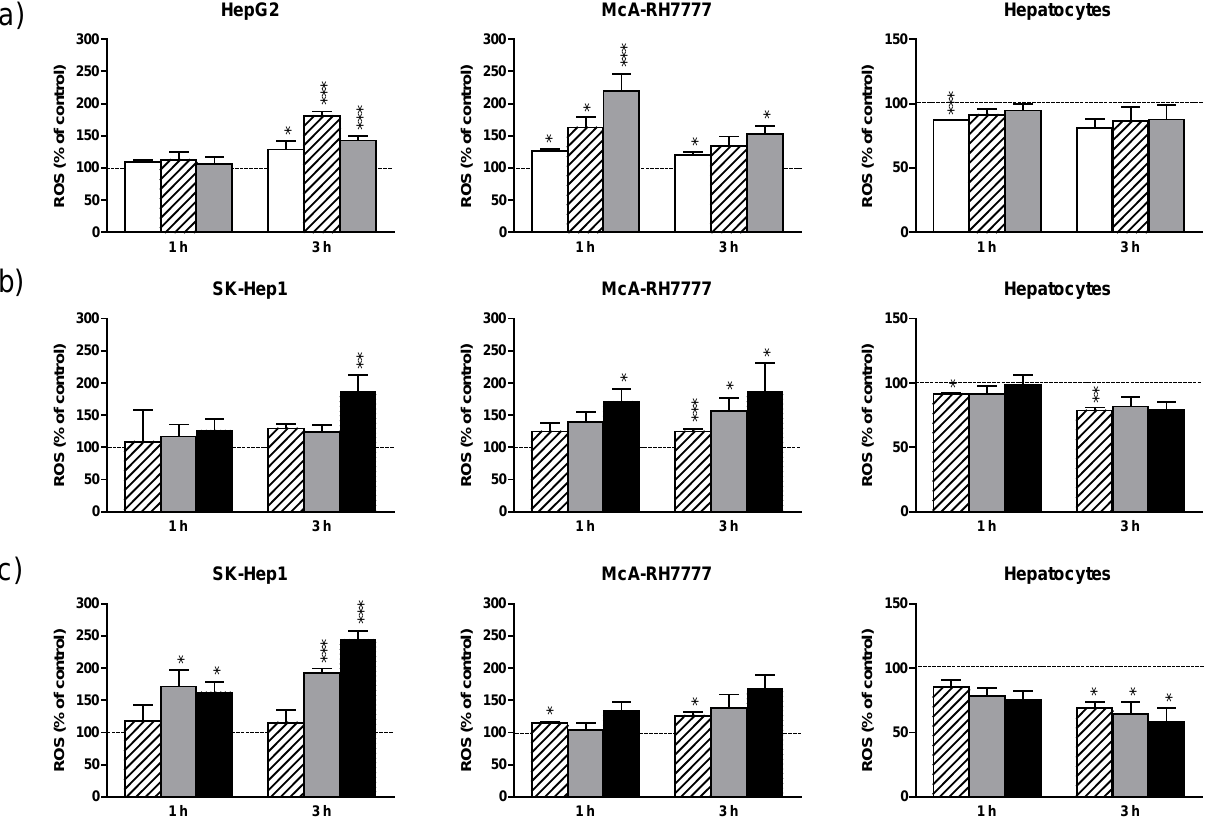
Figure 2. Effects of ( a ) Vismia ; ( b ) P. krukoffii ; and ( c ) P. putumayoense leaf extracts on ROS formation in hepatoma lines, and primary cultures of rat hepatocytes. The cells were incubated without (control) or with the plant extracts at the concentrations: 19 µg/mL; 38 µg/mL; 75 µg/mL; 150 µg/mL for 1 and 3 h. After incubation, cells were loaded with the fluorescent probe as described in Mat. and Meth. Results are expressed as n = 3 experiments. * p < 0.05; ** p < 0.01; *** p <